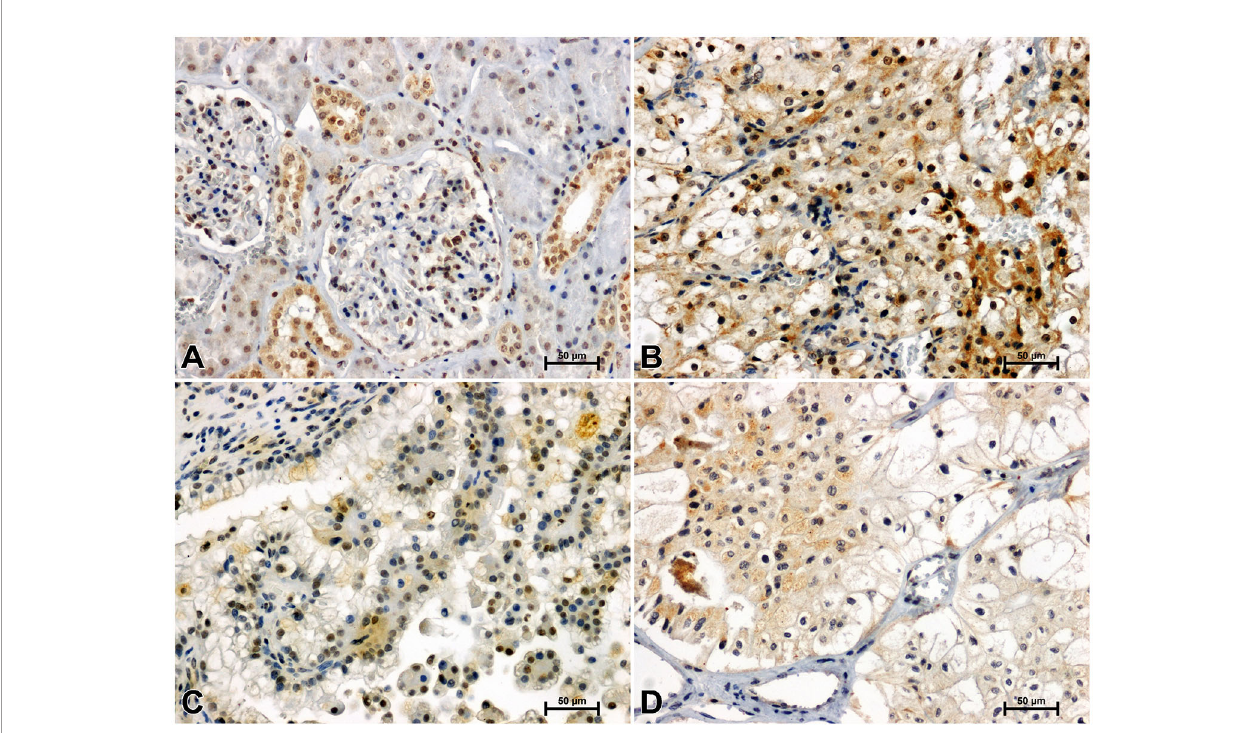
FIGURE 5 | Immunohistochemical reaction determining CacyBP/SIP in non-malignant kidney (A) and clear cell RCC (B) , papillary RCC (C) , chromophobe RCC (D) .